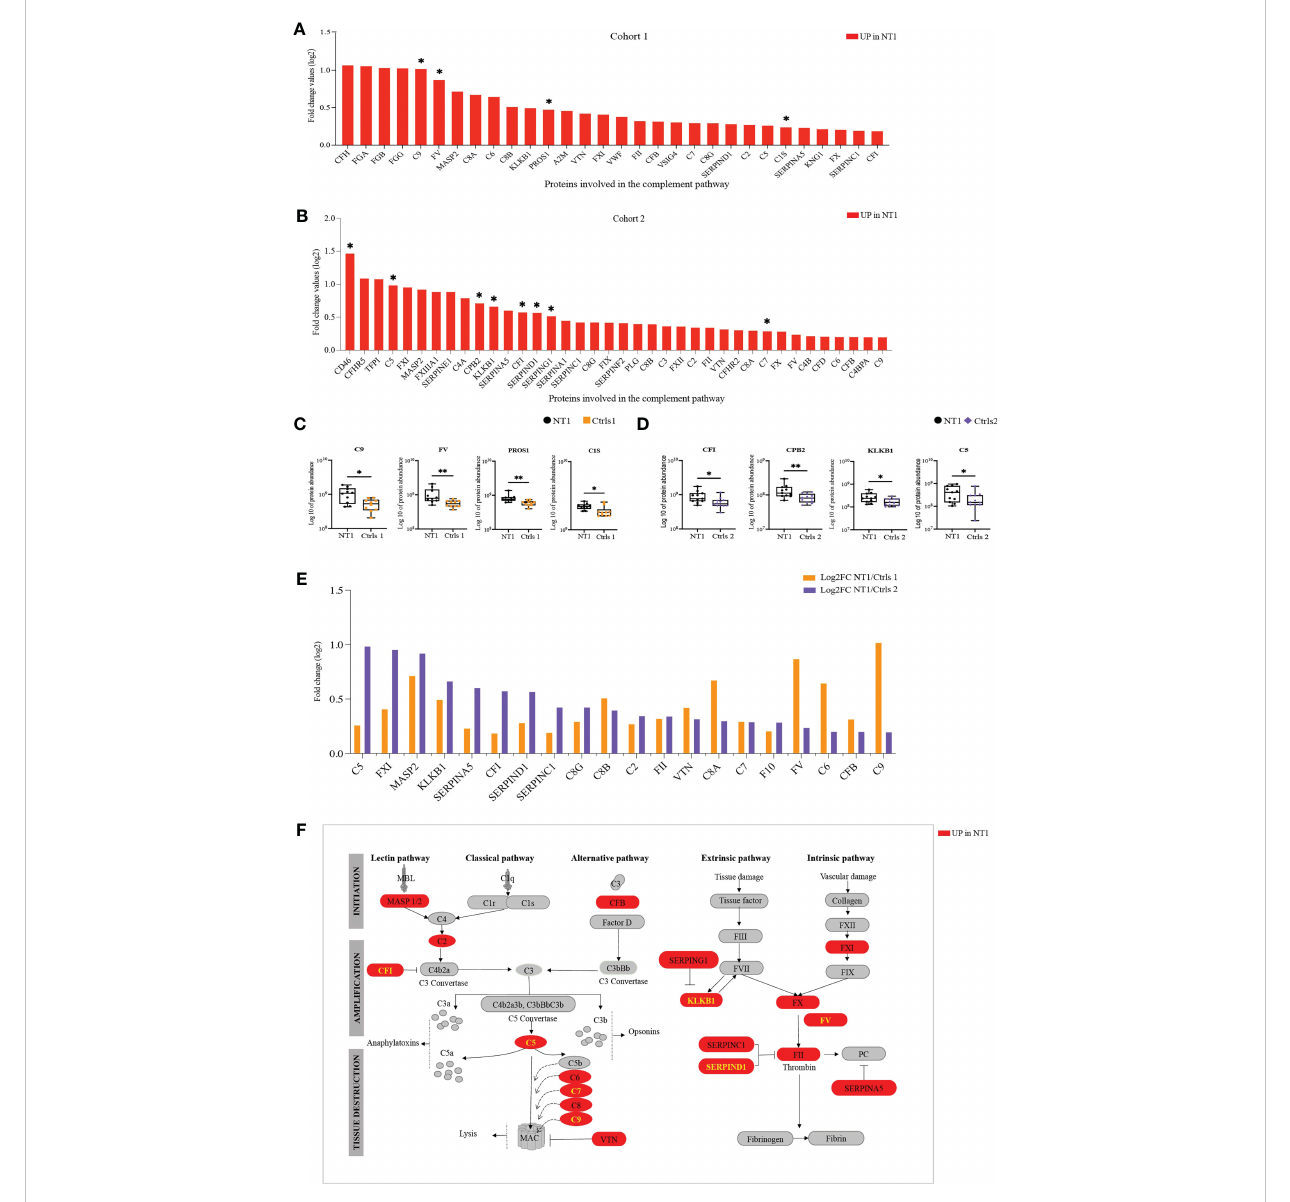
FIGURE 5 The complement and coagulation pathway are enriched in NT1 patients. (A) The proteins involved in the complement and coagulation pathway, their log2 fold change ratio in cohort 1. (B) The proteins involved in the complement and coagulation pathway, their log2 fold change ratio in cohort 2. (A, B) The proteins that are signi fi cantly regulated in the CSF of NT1 patients are indicated with a star (p-value<0.05; Limma test). (C) Boxplots of the differentially regulated proteins in cohort 1. (D) Boxplots of selected proteins in cohort 2. *p-value<0.05, **p-value <0.01; Mann Whitney test. (E) Complement and coagulation proteins differentially regulated in both cohort 1 and cohort 2 and their log2 fold change. (F) Representation of the complement and coagulation proteins highlighting in red proteins up-regulated in the CSF of NT1 patients from both